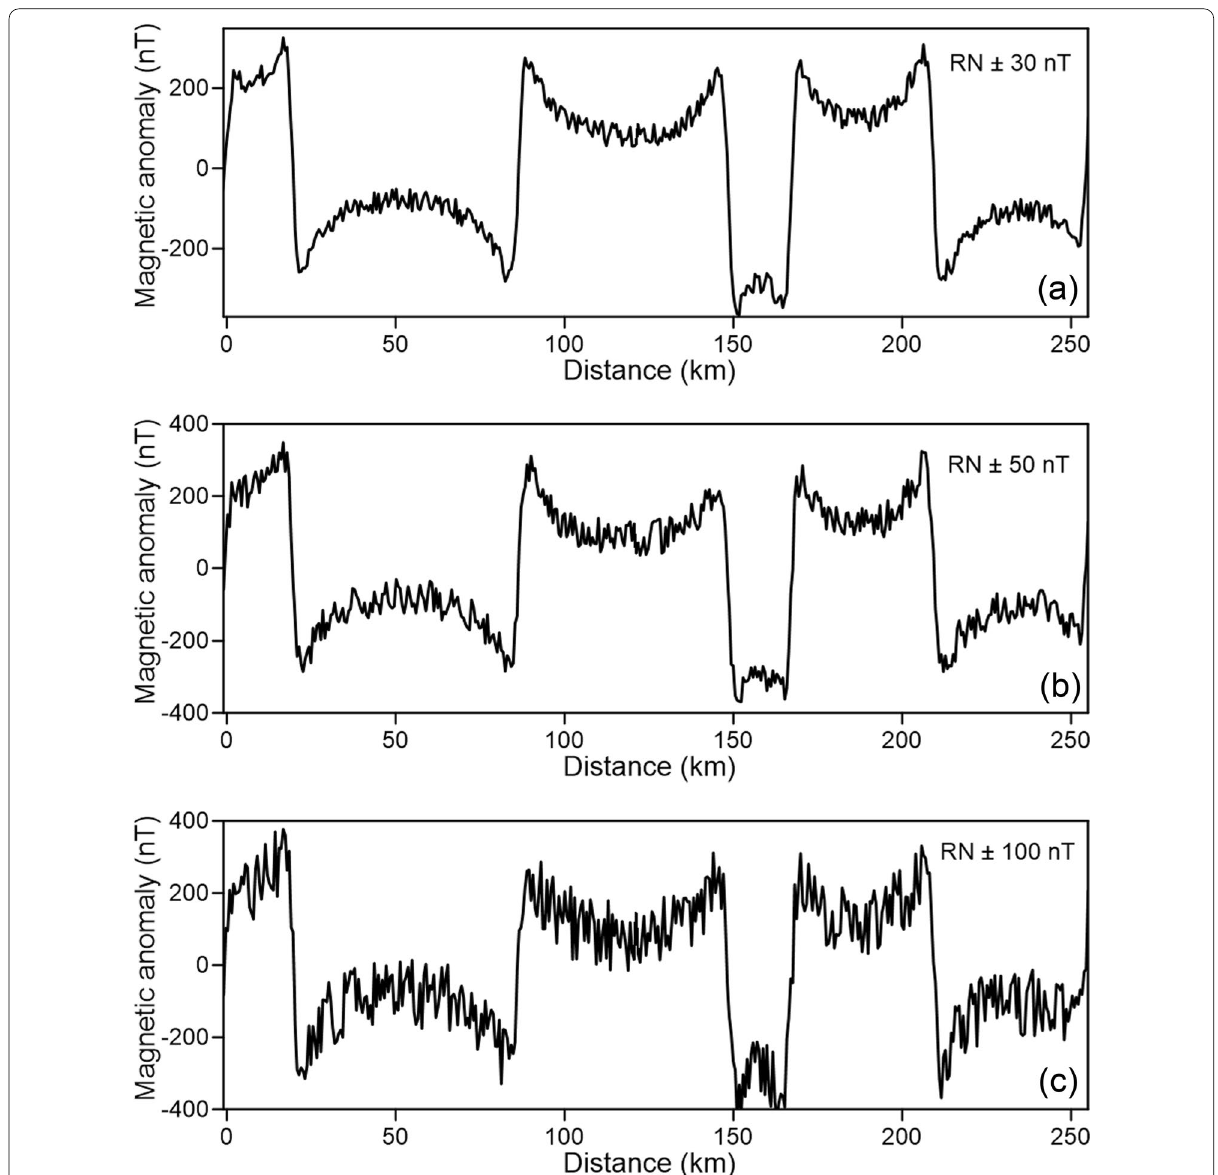
Fig. 11 The marine magnetic anomaly profiles with different amplitude of random noises. a Magnetic anomaly profile with Magnetic anomaly profile with